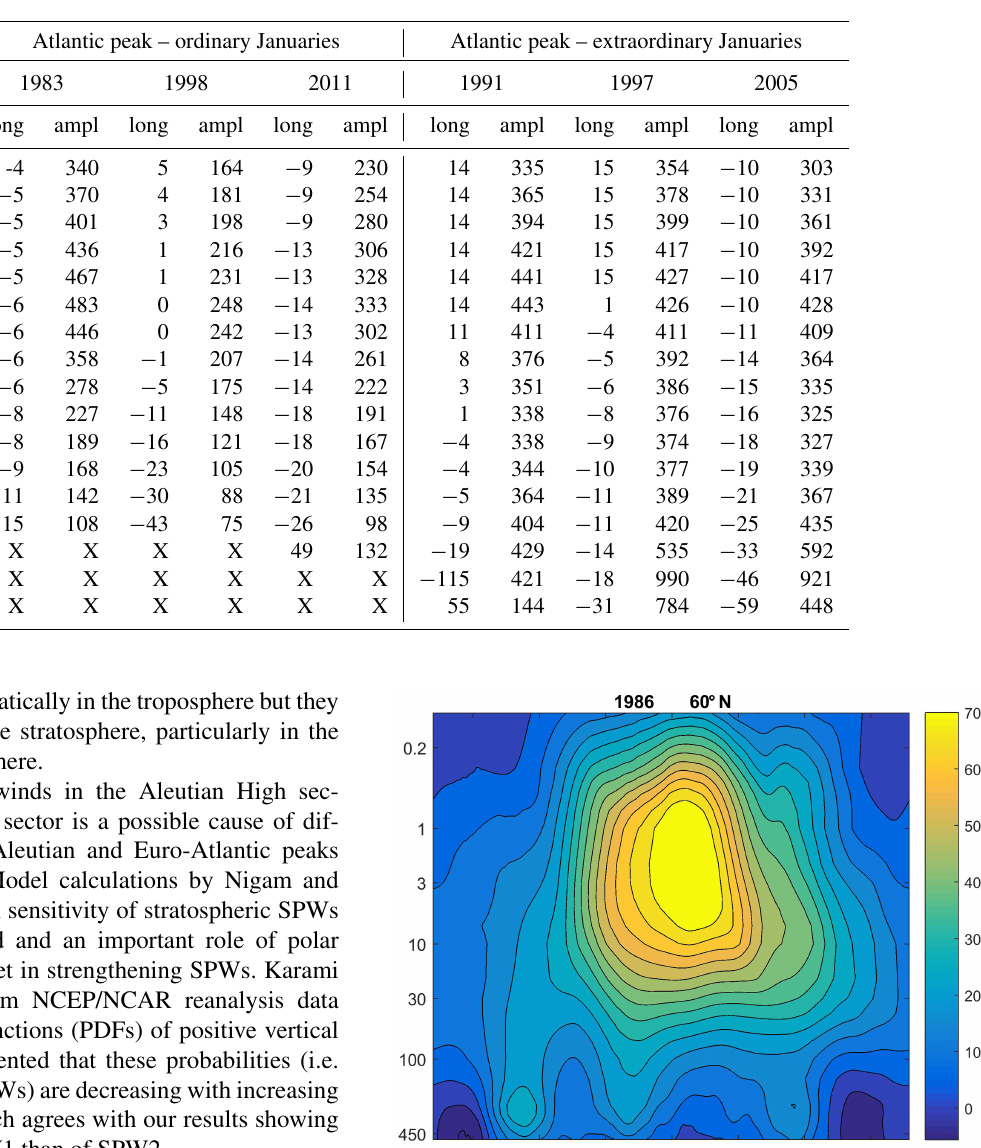
Table 3. Height profiles of “Atlantic” peak of SPW2 at 60 ◦ N for three ordinary and three extraordinary Januaries. Longitudes (long in ◦ E) and amplitudes (ampl in metres) of this peak are shown for 17 levels between 500 and 0.1hPa based on MERRA data.